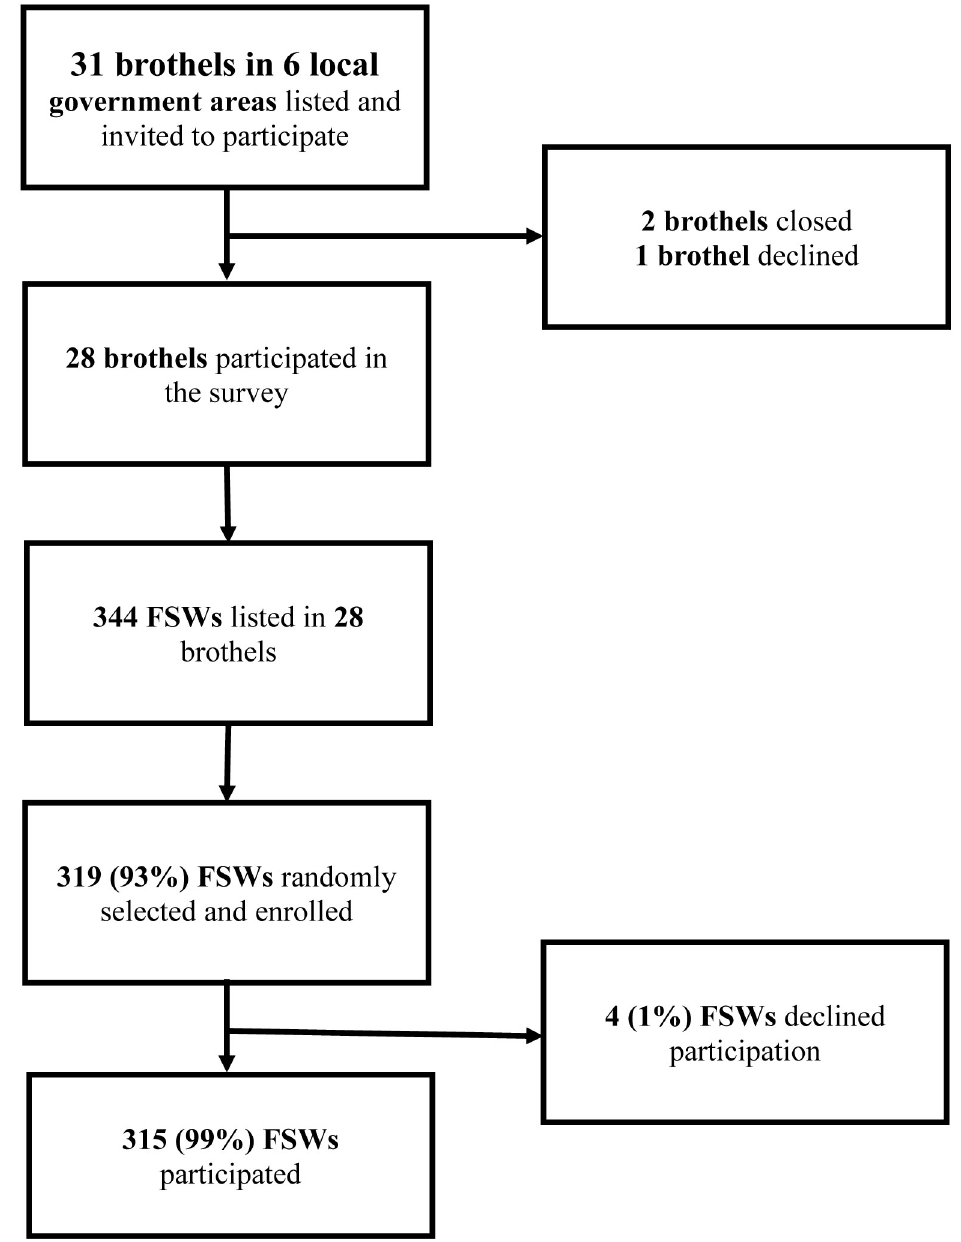
Fig 1. Brothel-based female sex workers enrolment flow for SHINI study in Ibadan, Nigeria.